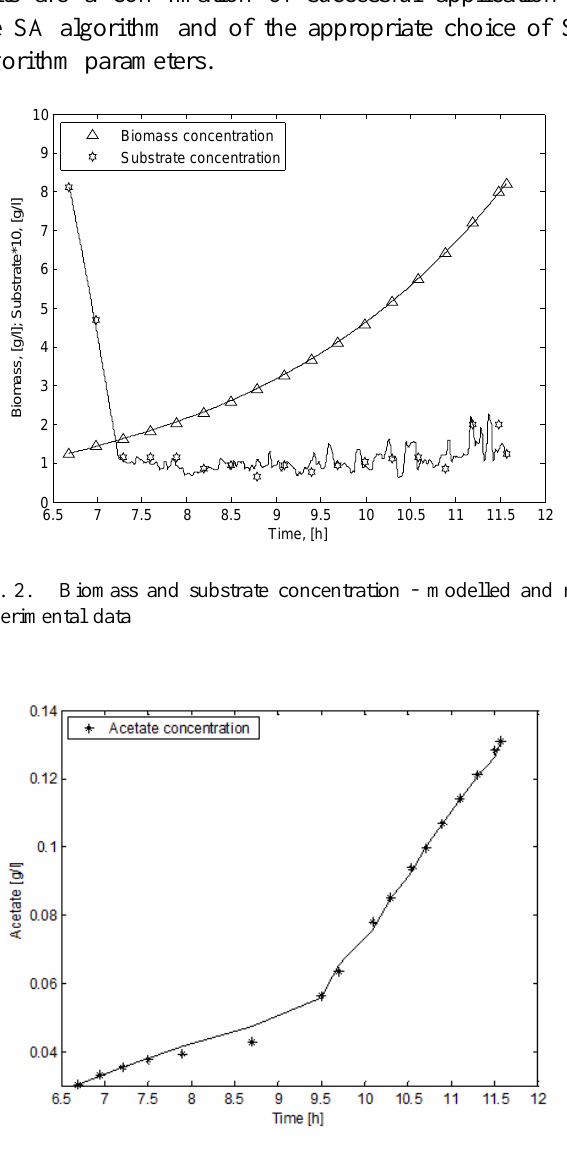
Fig. 3. Acetate concentration - modelled and real experimental data